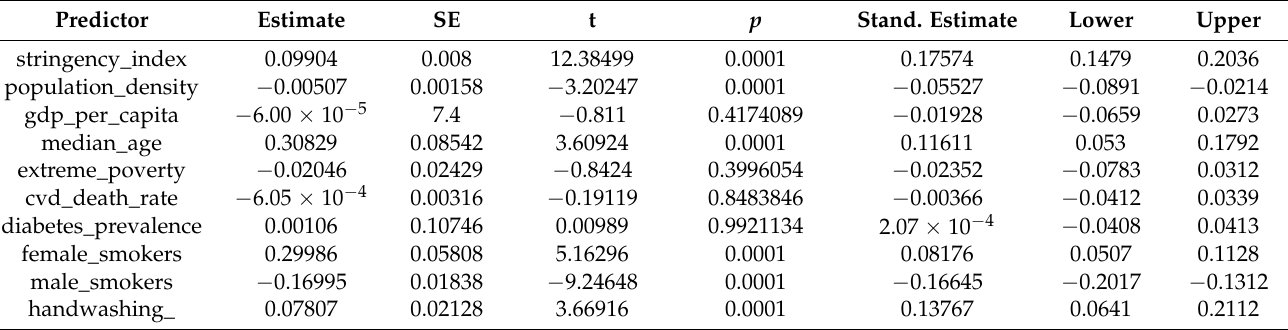
Table 2. Overall risk factors associated to mortality rate